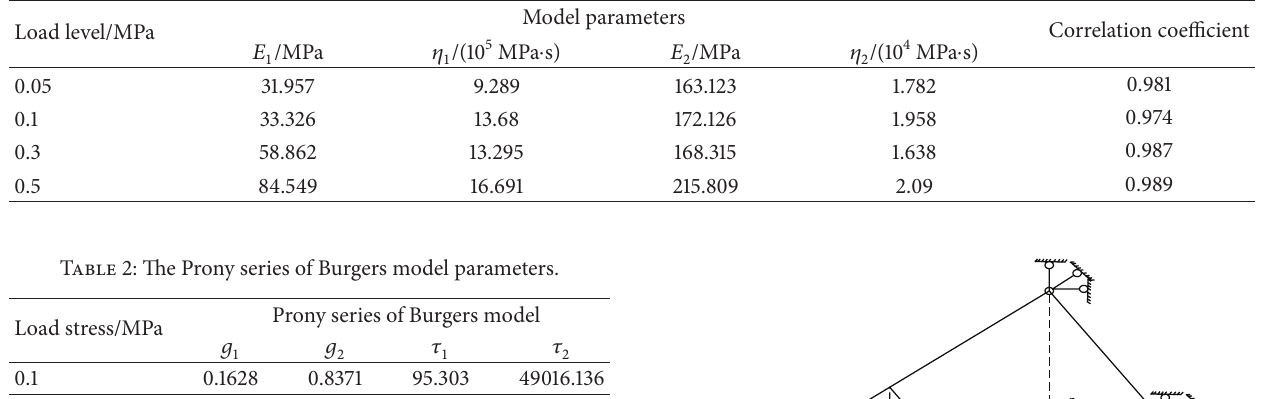
Table 1: Parameters of Burgers model.